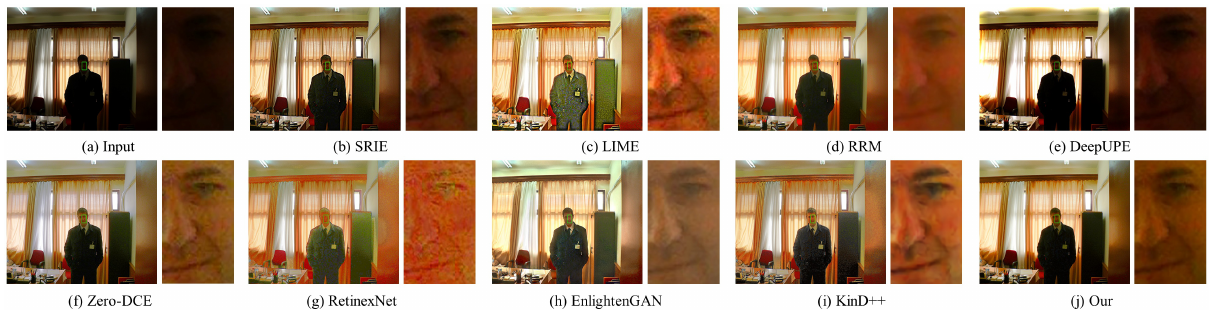
Figure 8. Visual comparison of low-light image enhancement on an image from the DICM dataset.